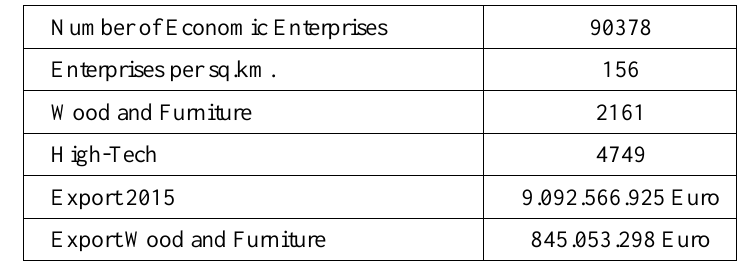
Table 1: Brianza 2005 - Facts and